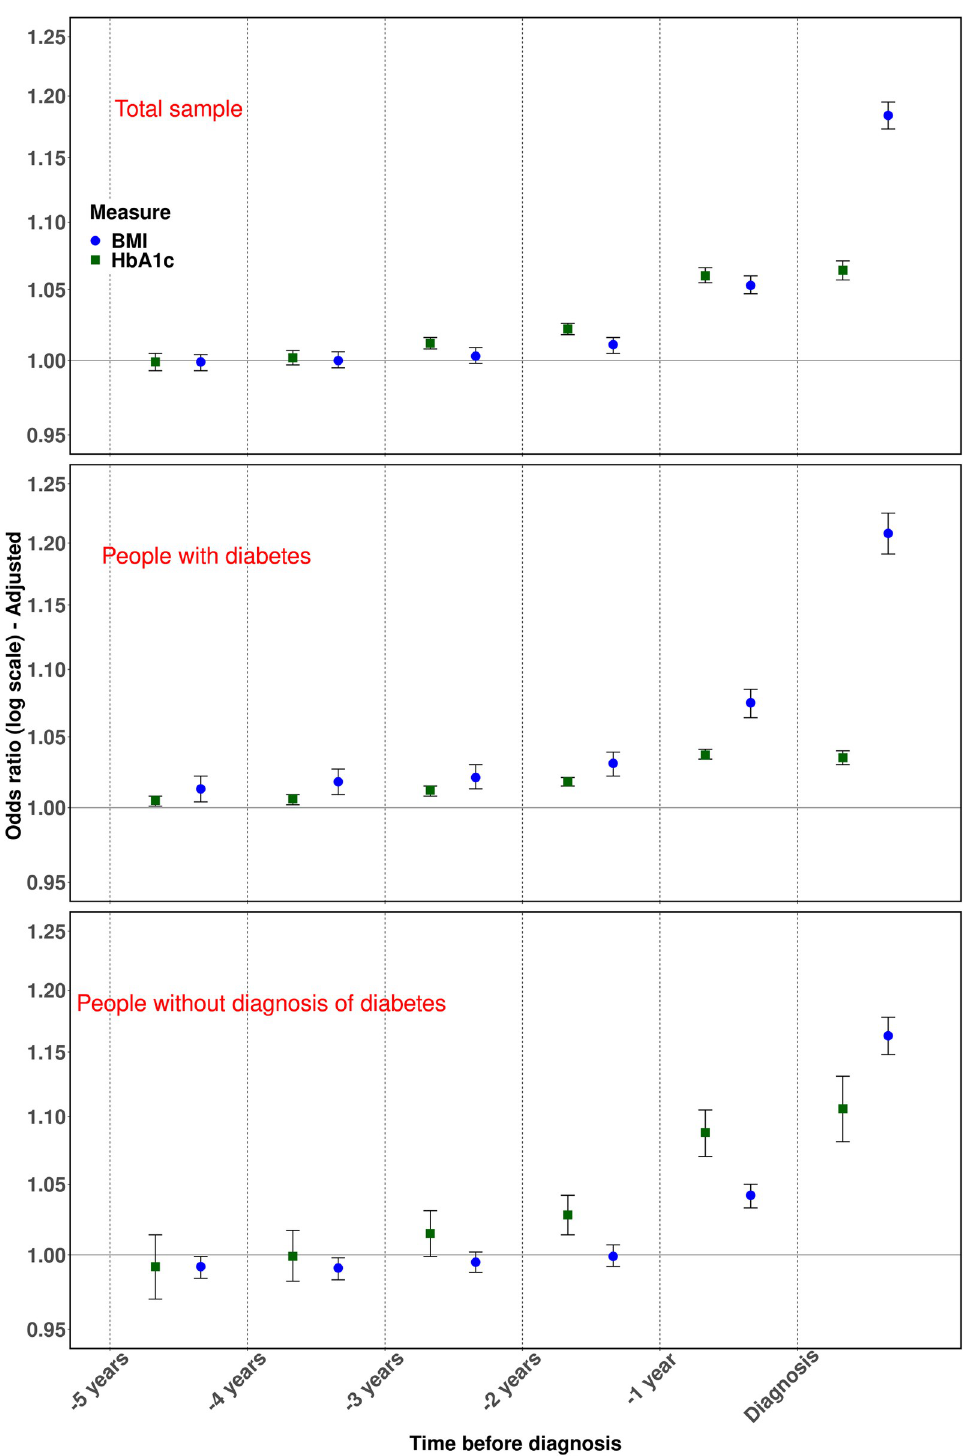
Fig 3. Adjusted odds ratios and 95% confidence intervals for the association of pancreatic cancer with a 1 kg/m2 decrease in body mass index (BMI) between cases and controls (blue circles) and a 1 mmol/mol increase in glycated haemoglobin (HbA1c) (green squares) from 5 years before pancreatic cancer diagnosis. The top plot is for the total study sample. The two further plots show subgroup analysis by the diabetes status.